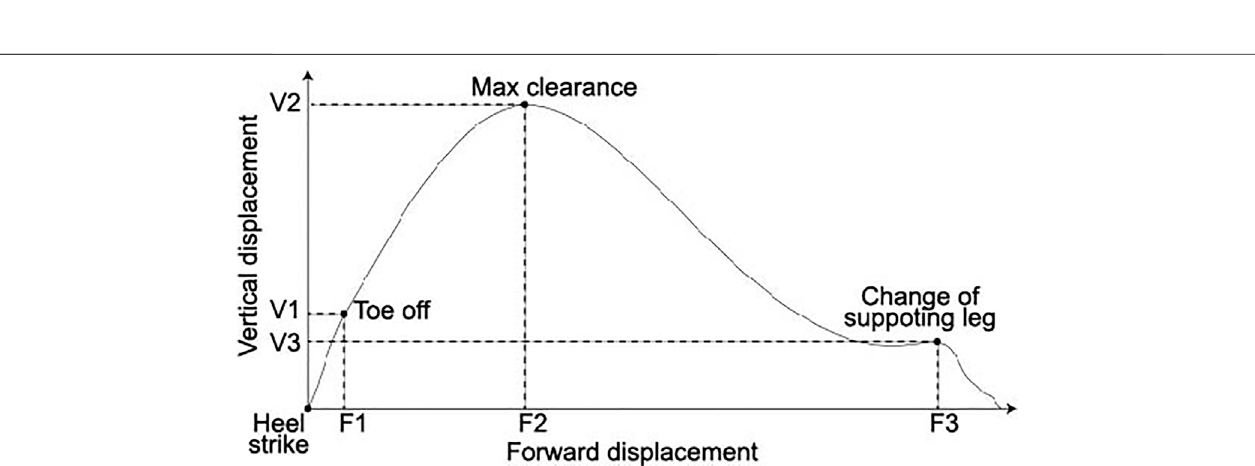
FIGURE 1 | (A) The experiment task. Participants walked and turned in a straight corridor, giving over 60 strides. (B) The IMU and a belt to attach the IMU on the shank. (C) The belt with the IMU around the shank.